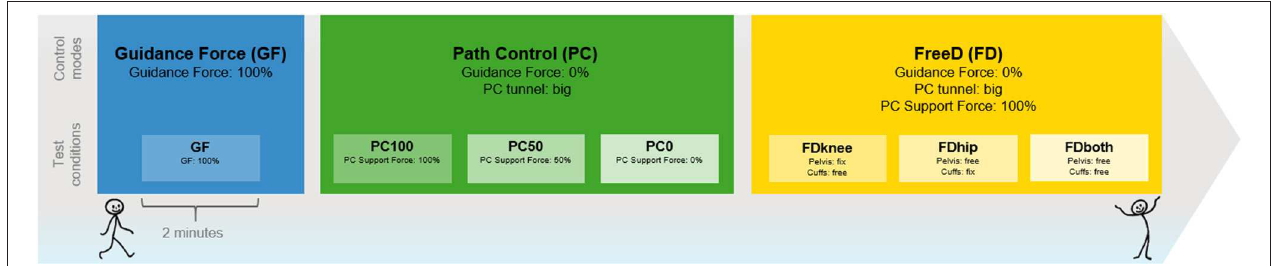
FIGURE 1 | Test procedure. The illustrated order helps to understand the increase of kinematic freedom. During the tests, the order was block-randomized. Each condition lasted 2min with a 1-min break in between. GF, Guidance Force condition (blue); PC, Path Control condition (green), FD, FreeD condition